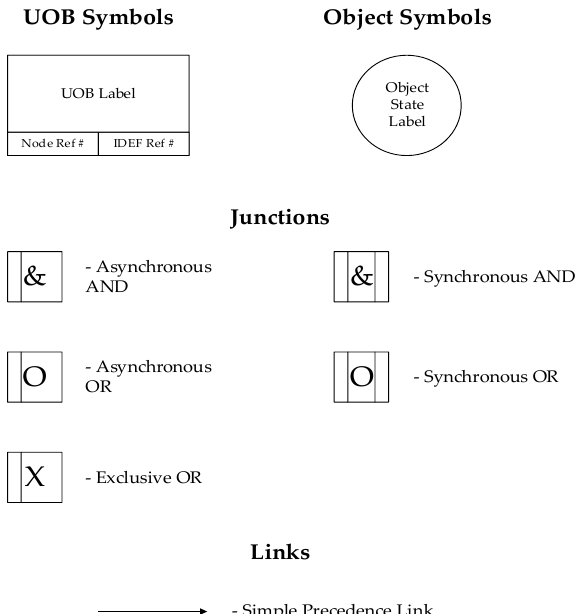
Figure 2. Symbols used for Integrated DEFinition 3 structured diagramming technique (IDEF3) process description schematics.